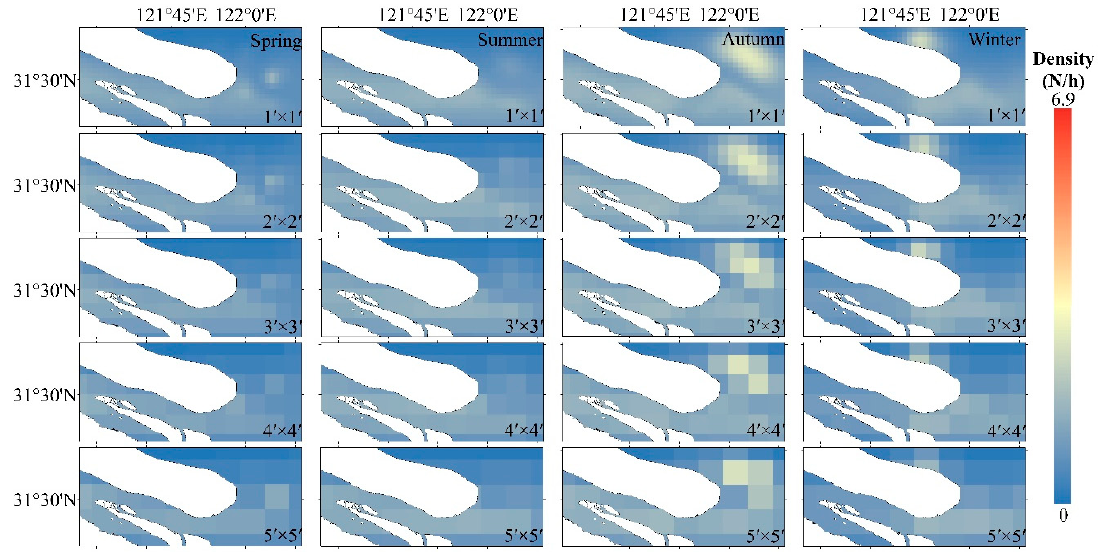
Figure 7. Spatial distribution of Coilia nasus predicted using interpolated environmental variables from different spatial resolutions in 2014 in the Changjiang River estuary.